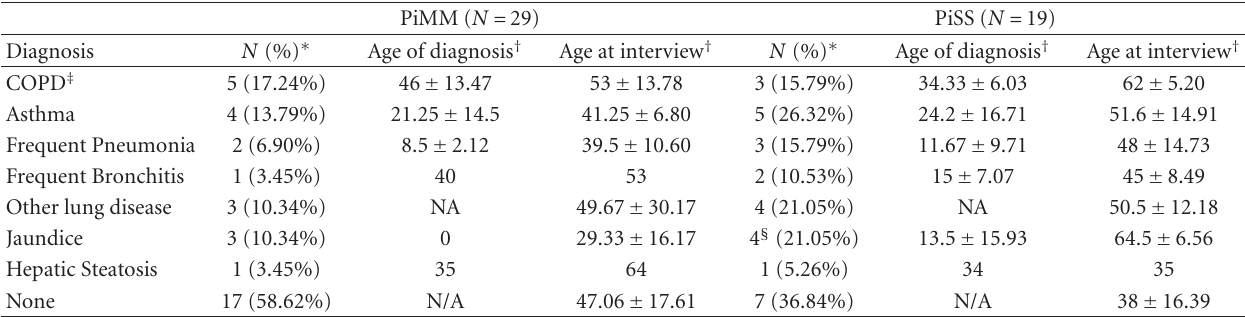
Table 3: Lung and liver disease in 19 individuals with the PiSS genotype and 29 controls with the PiMM genotype.